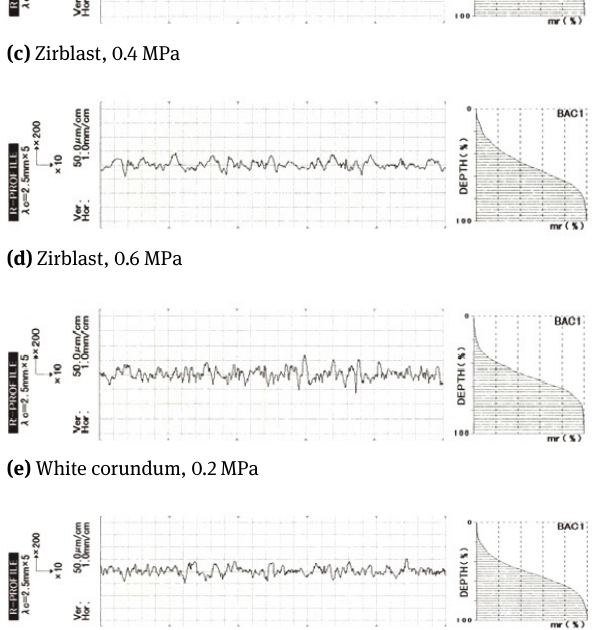
A sharp-edged group of blasting abrasives was rep- resented by white corundum. The values of the param- eters Ra, Rz and Rt decreased with air pressure increas- ing. Surface blasted with Zirblast reached higher values of roughness parameters compared to white corundum, Fig. 4–6. The RSm value increased compared to as-made material by 85% and the value of RPc parameter decreased by 100%. For both abrasives, despite their shape and a ma- terial difference, a similar course of roughness parameters was recorded, however the values were higher for white corundum. A recommendation of appropriate blasting pa- rameters and abrasives depends on the specific demands on the implant